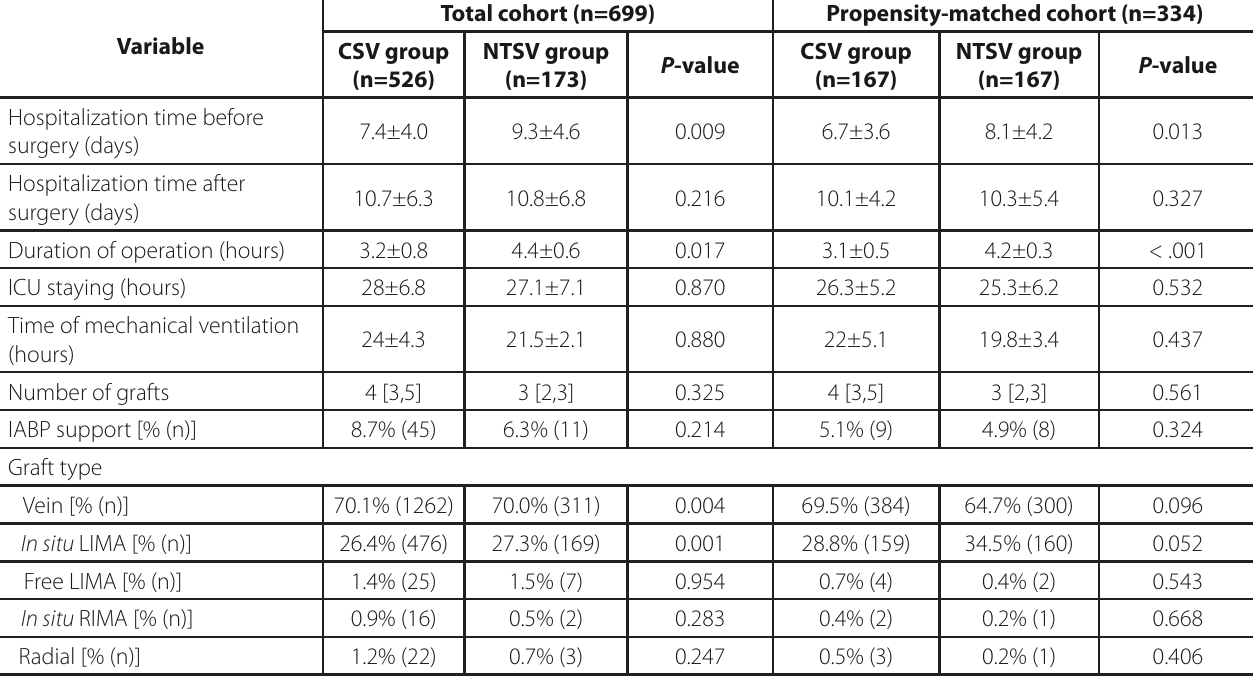
Table 2. Perioperative variables for total and propensity-matched